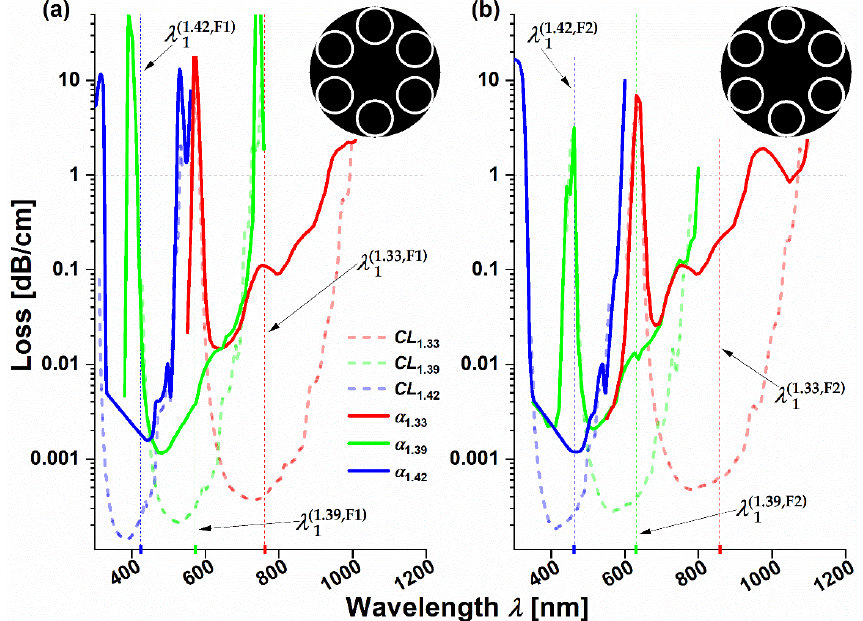
Figure 2. Loss spectra of fibers F1 ( a ) and F2 ( b ) versus the wavelength ( λ ) for 3 different values of the refractive index of aqueous liquids filling their microstructures: 1.33, 1.39 and 1.42. The confinement losses of both fibers ( CL , dashed lines) are shown in order to better mark the presence of the antiresonant windows. The total losses ( α , solid lines) of both fibers additionally account for the water absorption. The red, green and blue ticks and dotted lines at the X-axis (additionally indicated by the black arrows) mark the central wavelengths of the first-order ( m = 1) antiresonant bands of F1 and F2, calculated at α = 1 dB/cm for each refractive index (RI). The respective values of λ ( 1.39,F1 ) ( 1.42,F1 ) λ , λ are 761, 572 and 424 nm for the fiber F1, while for the fiber F2 λ 1 1 ( 1.42,F2 ) and λ are 859, 631 and 462 nm. The insets in the upper-right corner of each spectrum show 1 the cross-sections of the microstructures of F1 and F2, with F2 having slightly thicker capillary walls and a larger core compared to the fiber